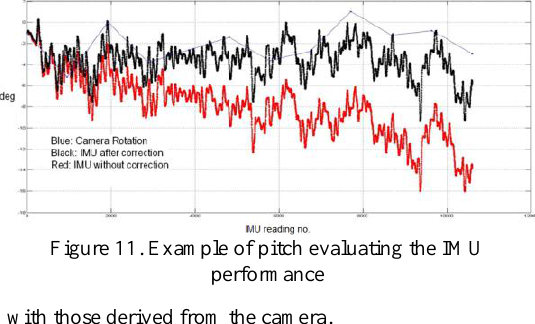
Figure 11. Example of pitch evaluating the IMU